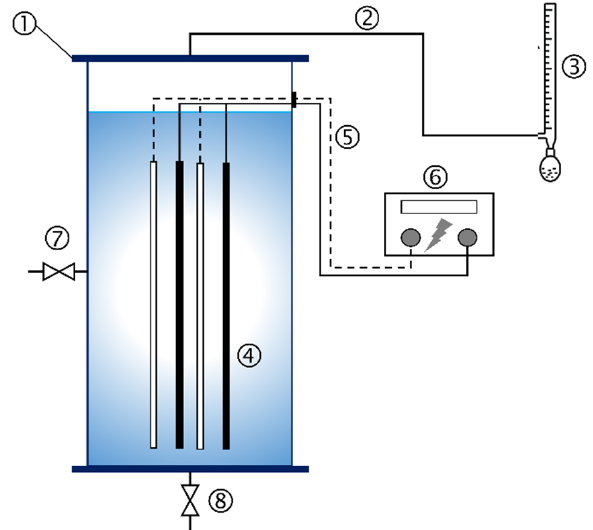
Figure 1. Experimental set-up in the batch column reactor: (1) column test, (2) gas collection pipe, (3) soap film meter, (4) electrode plates, (5) electrical wire, (6) DC generator, (7) sampling port, and (8) waste drainage port.